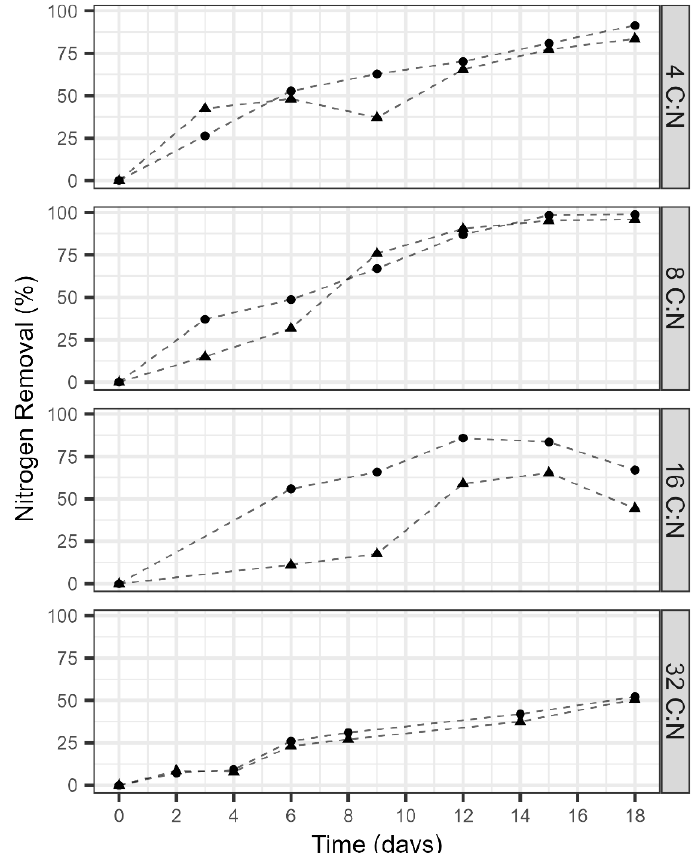
Figure 3. Nitrogen removal during an 18-day period at C:N ratios of 4, 8, 16, and 32 with a continuous flow anode and recycle batch cathode. Triangles represent NO 3 -N removal and circles represent TN removal. Data shown is from one replicate reactor. Ammonium and nitrite concentrations were also measured but below the detection limits, thus, they are now shown.